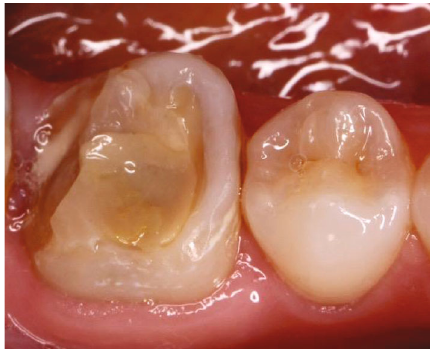
Figure 1: Initial situation.